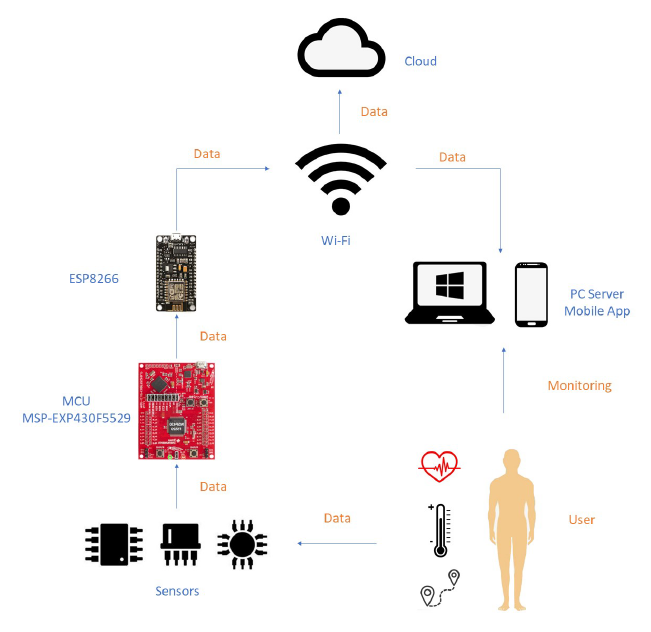
Figure 1. The architecture of the wireless physiological monitoring